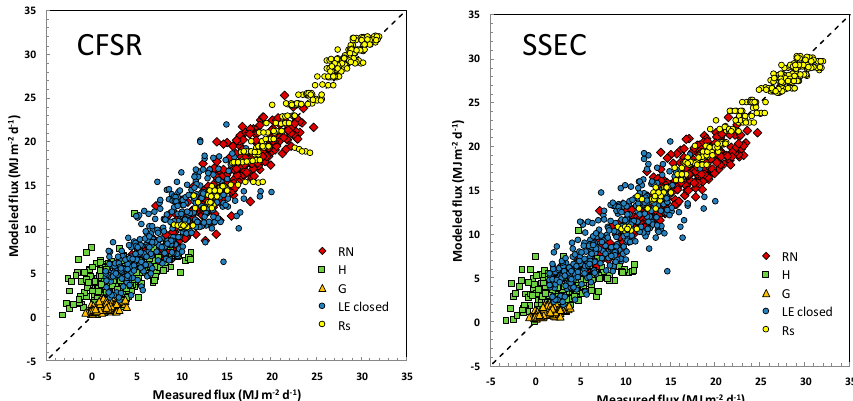
Figure 7. Energy flux partitioning generated with DisALEXI on clear Landsat dates using CFSR and SSEC insolation data as input compared to the tower flux observations.